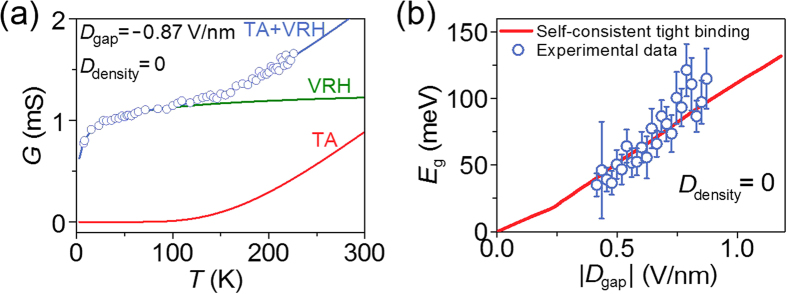
Thermal activation and variable range hopping conduction at the charge neutrality point.(a) Temperature dependence of conductance G at Dgap = −0.87 V/nm and Ddensity = 0 (charge neutrality point). The data were taken by ac measurements at zero dc bias and are fitted to the parallel conduction model (blue line), which consists of thermally activated conduction (red line) and variable-range-hopping conduction (green line). Best-fit parameters are Eg = 115 ± 23 meV and Th = 1.92 ± 0.59 K. (b) Band gap Eg estimated from the temperature dependence of conductance is plotted as a function of |Dgap|. Red line represents the prediction by self-consistent tight-binding calculation.